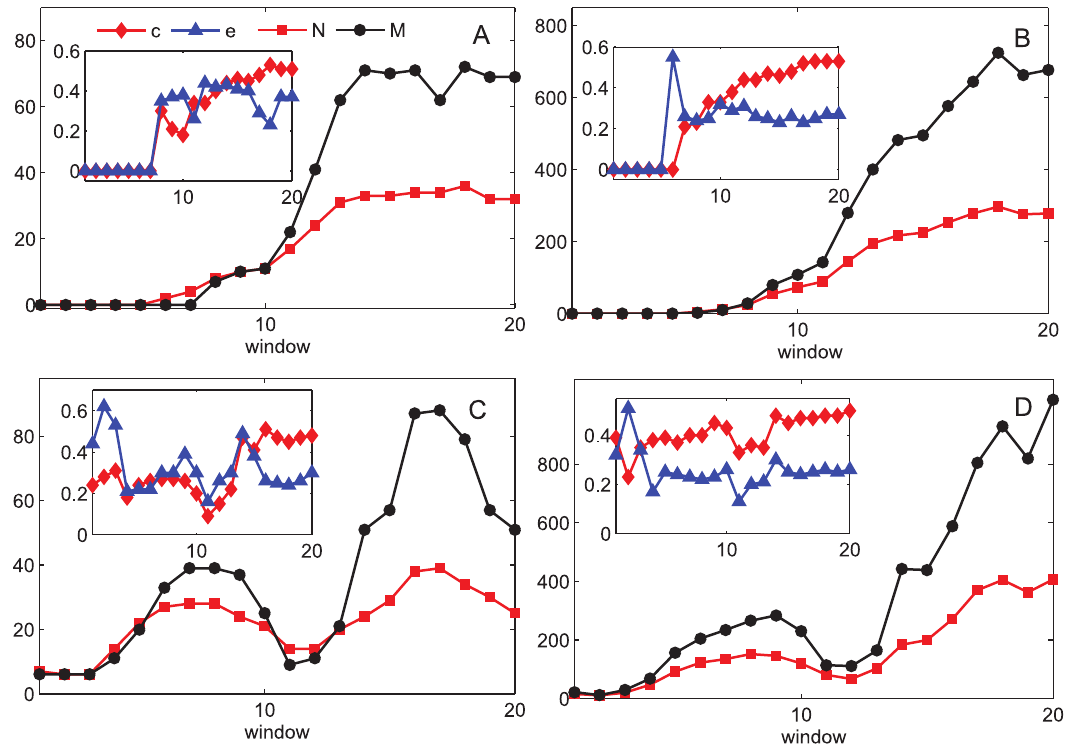
Figure 4. Measures of parameters of two egocentric scientific collaboration networks in their first 20 windows. Figures labeled A–B and C–D represent two scientists respectively. A and C: Numbers of nodes N , number of edges M , clustering coefficient c and network efficiency e in T-1 networks. B and D: Numbers of nodes N , number of edges M , clustering coefficient c and network efficiency e in T-2 networks in each window. The two scientists have their collaboration networks evolve in two different patterns. The egocentric networks of the first scientist (A and B) have a boost in size during window 10 to 13, while the egocentric networks of the second scientist (C and D) have two peaks of their sizes around window 7 and